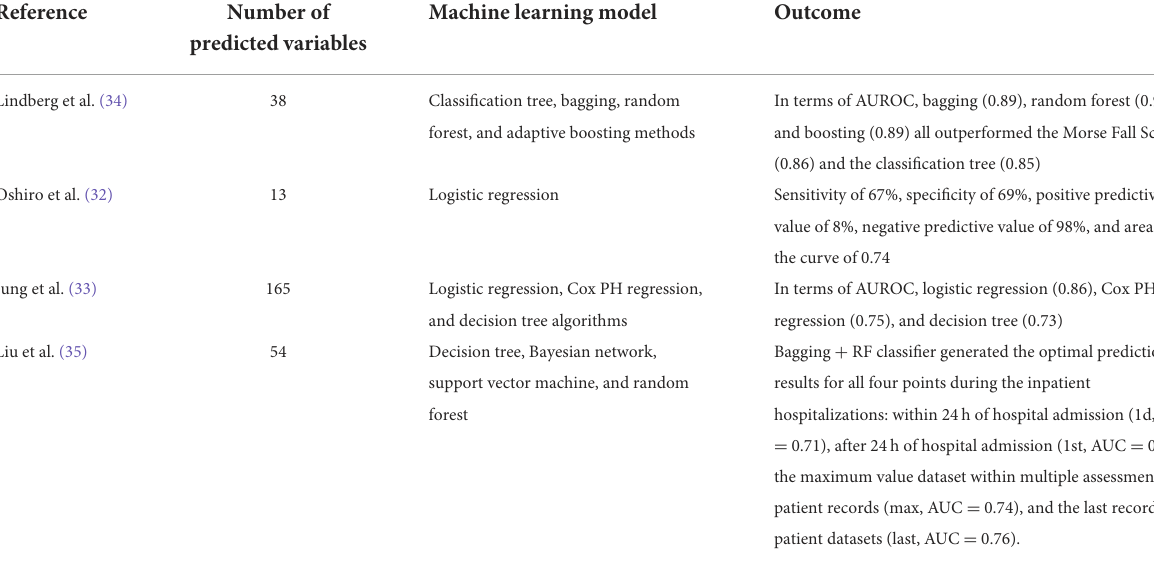
TABLE 1 Previous researches regarding fall risk prediction by machine